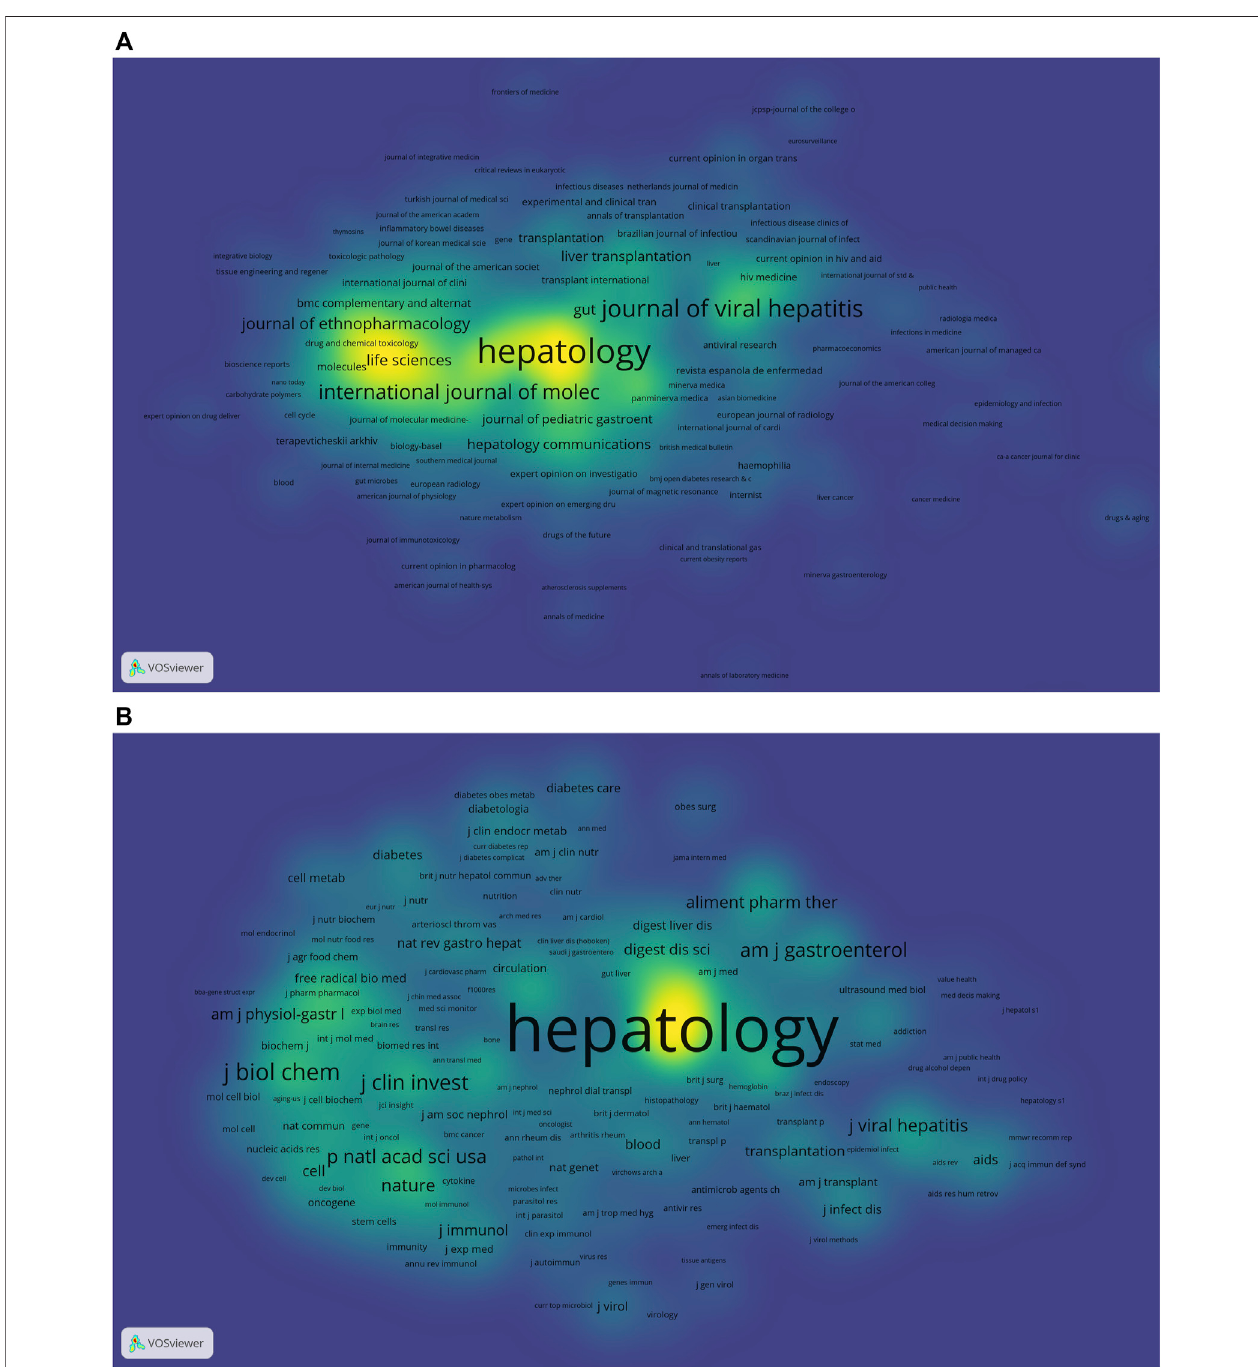
FIGURE4| Thedensitymaps (A) Journals; (B) Co-citedjournals.Notes:Thesizeofthewordandround,andtheopacityofyellowarepositivelyassociatedwiththe co-cited frequency.jpg.